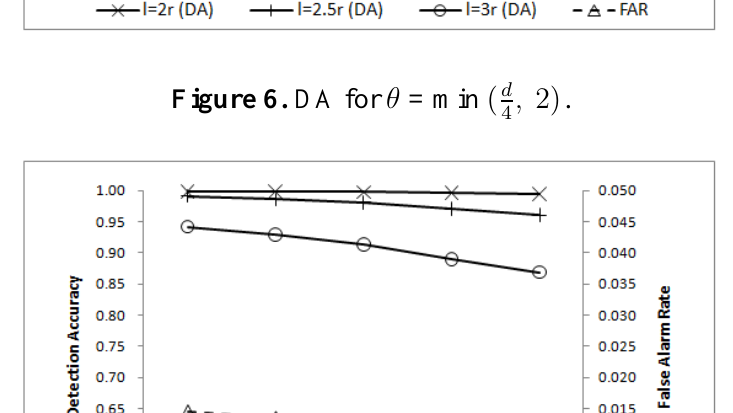
Figure 6. DA for θ = min ( d